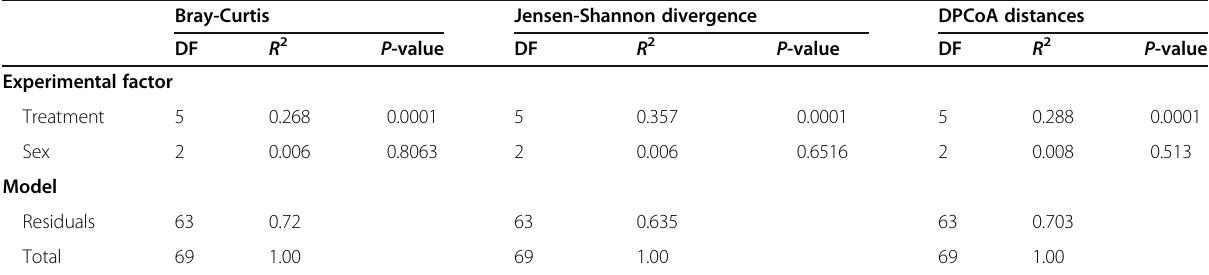
Table 2 Results of the PerMANOVA analysis using beta diversity